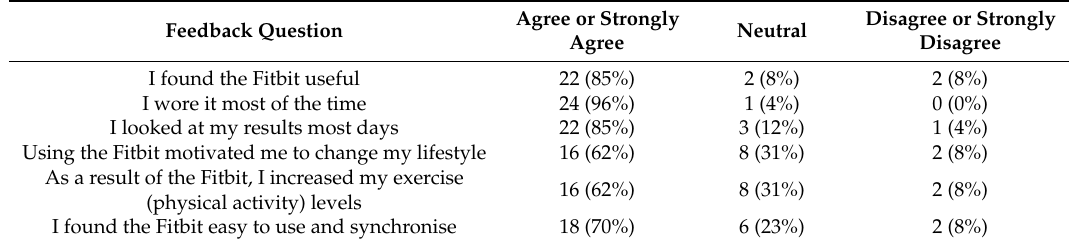
Table 5. Intervention group feedback regarding the activity